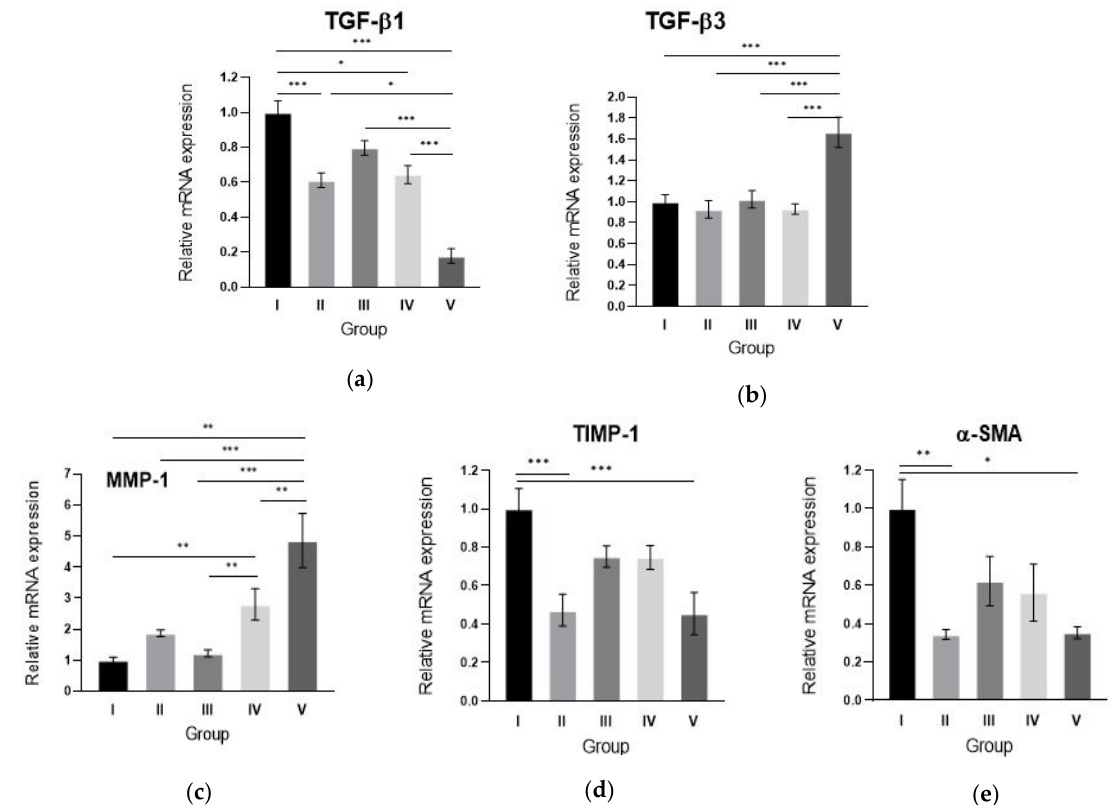
Figure 5. Alginate gel encapsulating dE1-k35 / sLRP6E1E2 changes TGF- β mRNA expression and other scar remodeling markers in pig scar tissues. ( a ) TGF- β 1 mRNA levels of Group V were 5-fold lower than that of Group I and 3-fold lower than that of Group IV scar tissues. ( b ) TGF- β 3 mRNA levels of Group V were 1.6-fold higher than that of Group I scar tissues and 1.8-fold higher than that of Group IV scar tissues. ( c ) MMP-1 expression levels of Group V scar tissues were significantly increased by 4.9- and 1.7-fold versus Groups I and IV scar tissues, respectively (*** p < 0.001). In contrast, TIMP-1 ( d ) and α -SMA expression ( e ) levels of Group V scar tissues were significantly decreased by 2.2- and 2.8-fold versus Group I scar tissues, respectively (* p < 0.05, ** p < 0.01, *** p < 0.001).